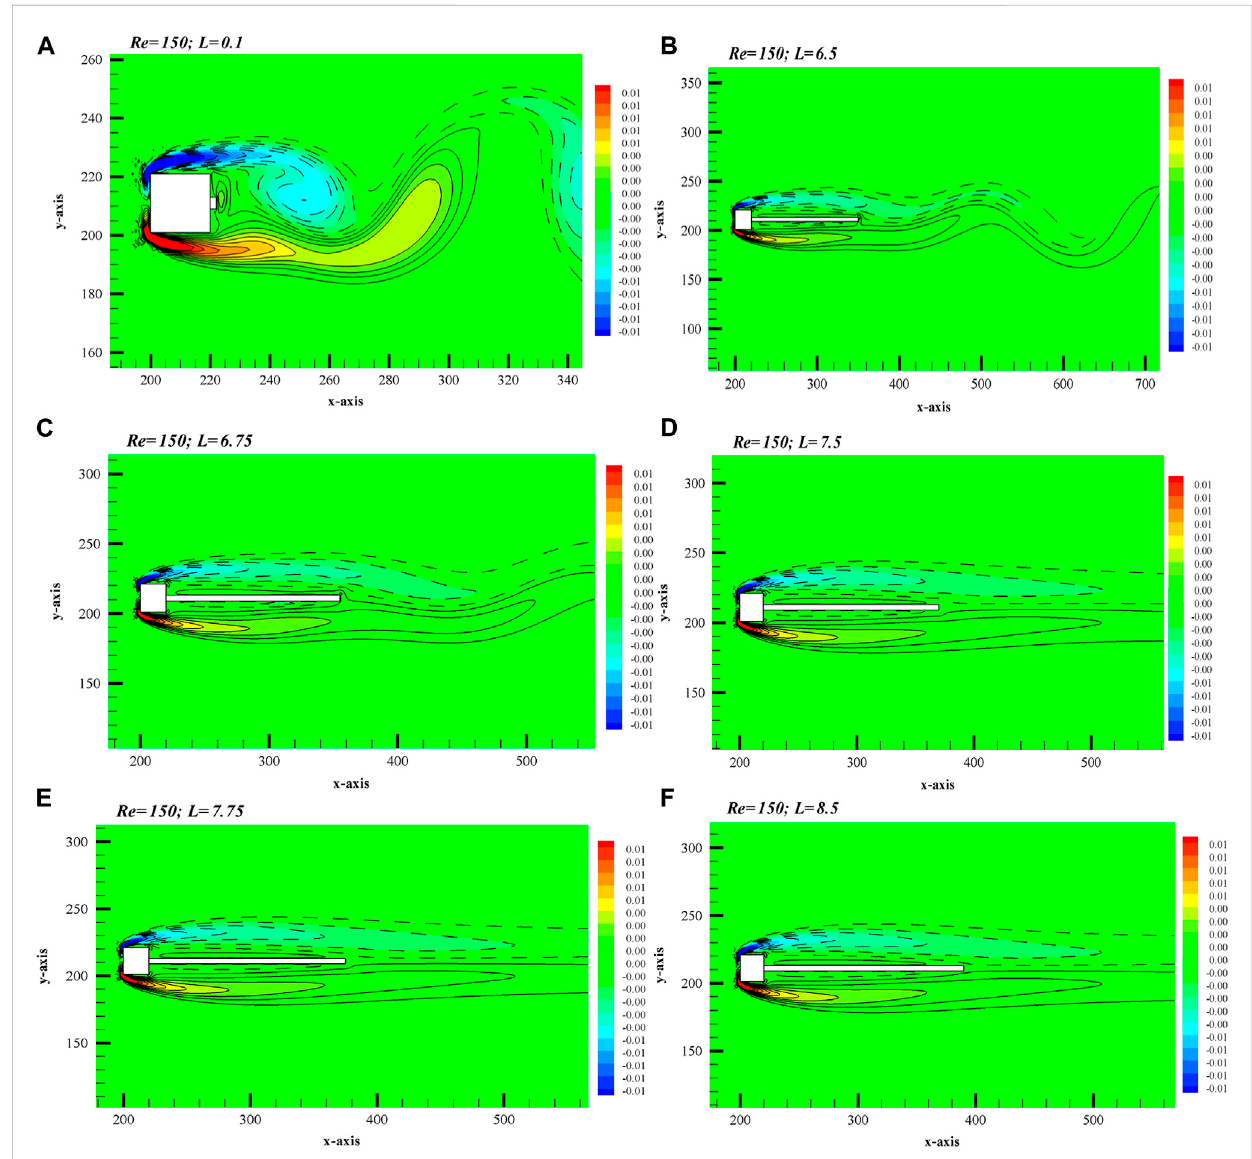
FIGURE 4 Vorticity graphs corresponding to different fl ow modes: (A,B) Unsteady, (C,D) Tranisent, and (E,F) Steady fl ow mode.